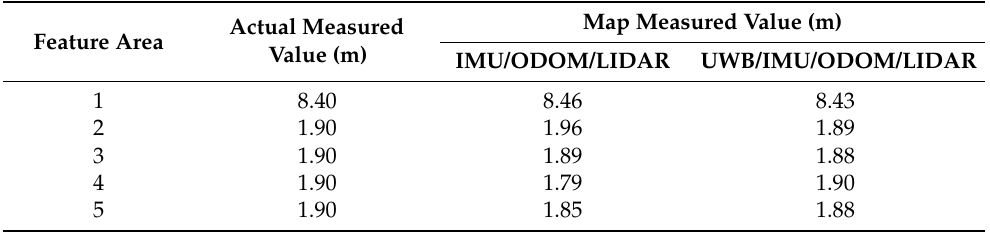
Table 1. Comparison of mapping error of different combinations of sensors.